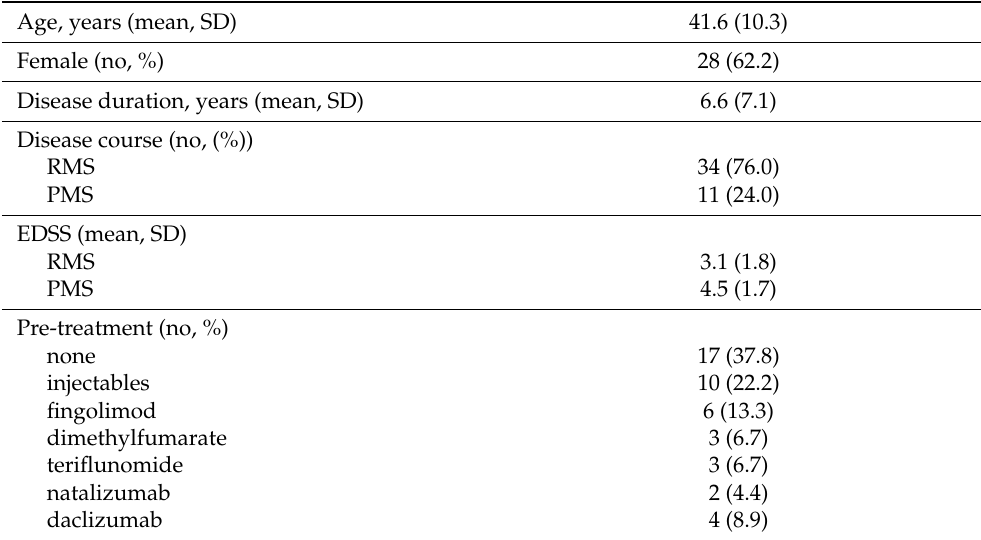
Table 3. Patient